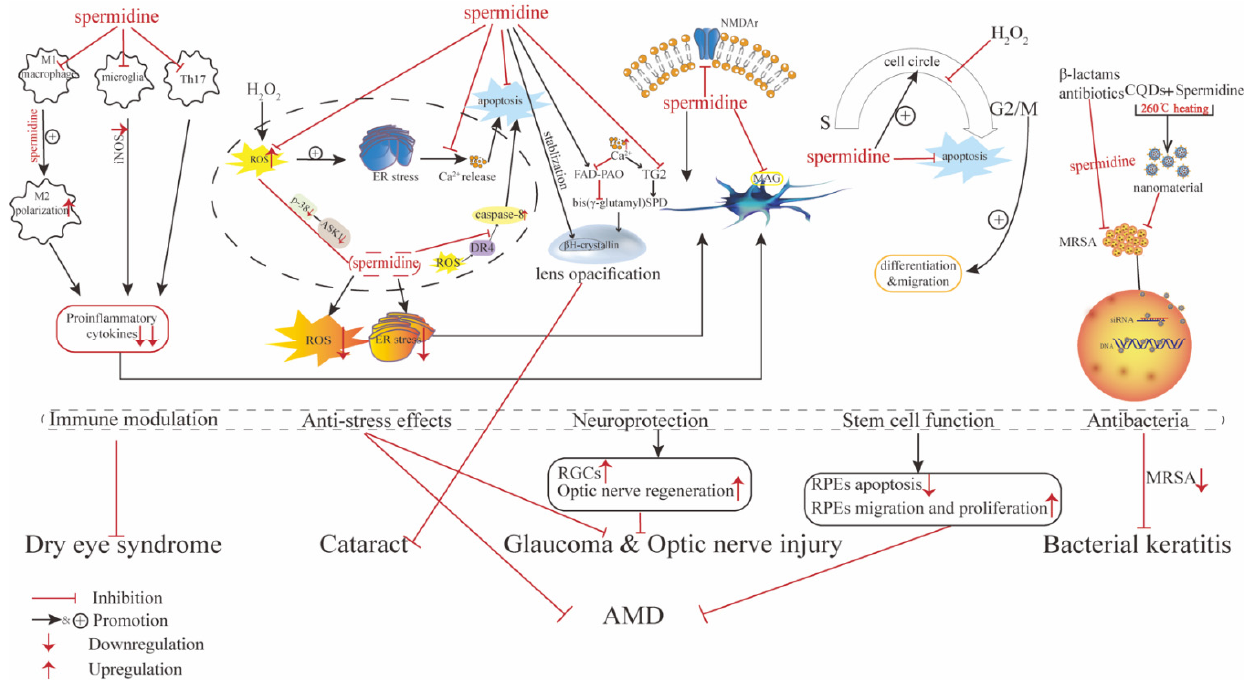
Figure 2. Protective effects and the mechanism that spermidine exerts on ocular diseases.